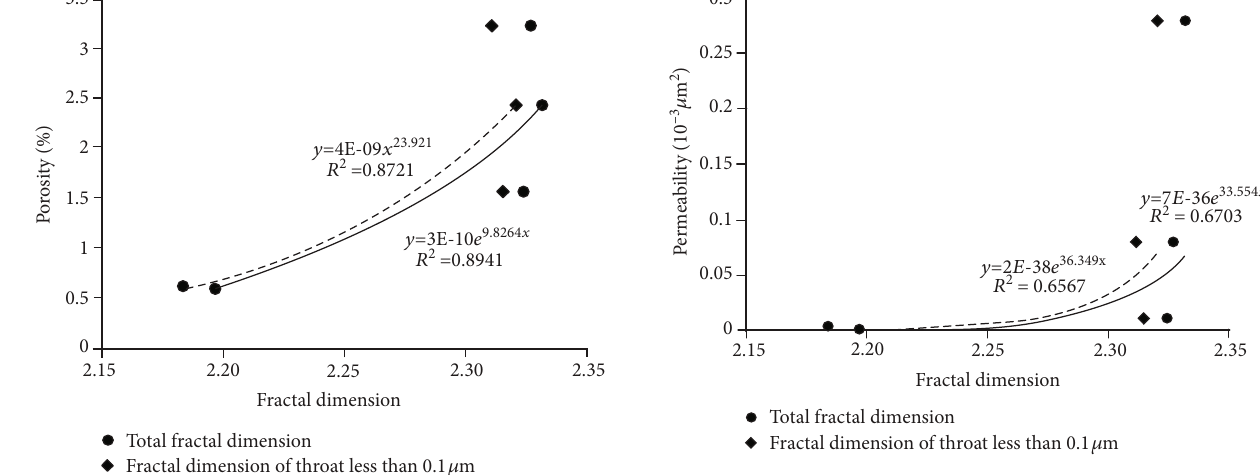
Figure 5: Relationship between fractal dimension of pore throats and permeability.